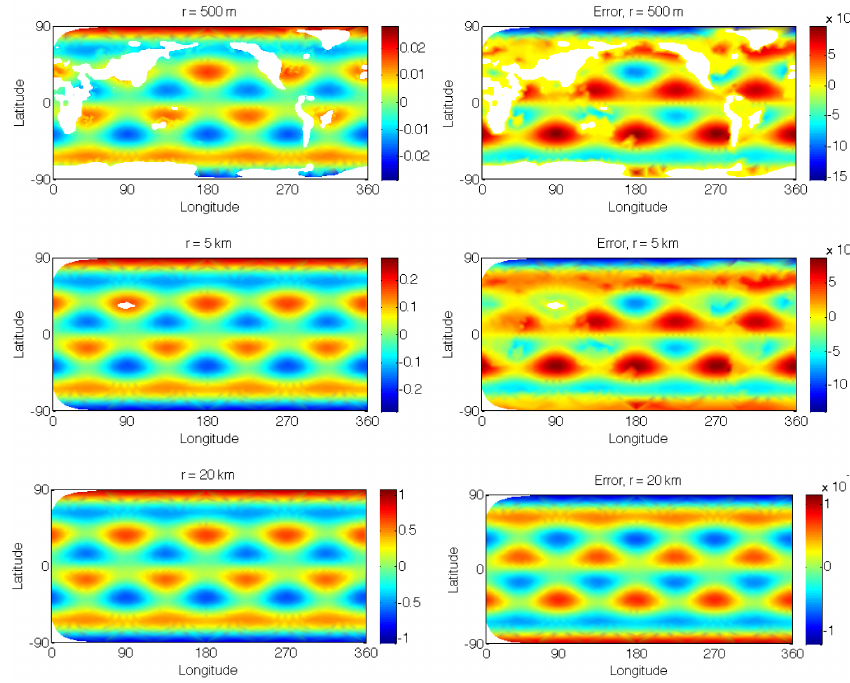
Figure 4. Left: numerical solution at different distances from the origin. Right: corresponding